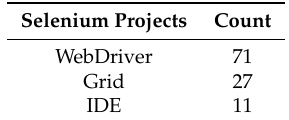
Table A1. 1.a. Which Selenium project do you use?